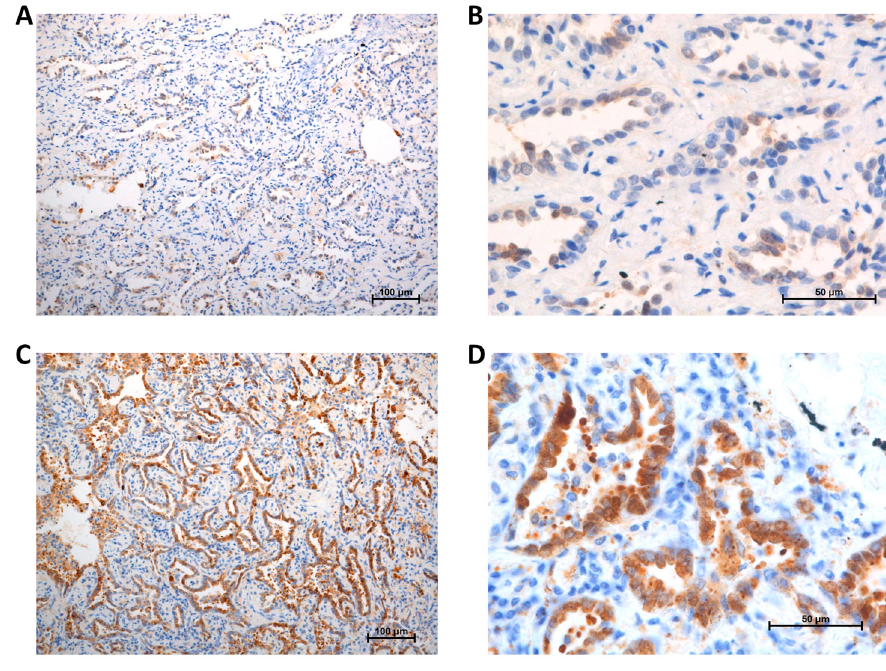
× ; ( B ) low, 400 × ; ( C ) high, 100 × ; ( D ) high, 400 × Figure 2. Galectin-3 expression: ( A ) low, 100 ×; ( B ) low, 400 ×; ( C ) high, 100 ×; ( D ) high, 400 ×. Figure 2. Galectin-3 expression: ( A ) low, 100